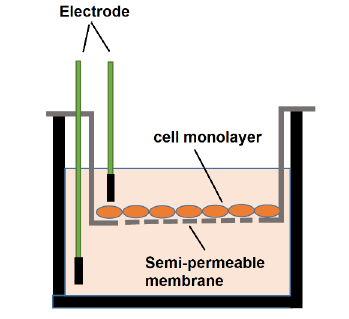
Figure 9. Schematic of Trans Endothelial Electrical Resistance (TEER) measurement system with chopstick